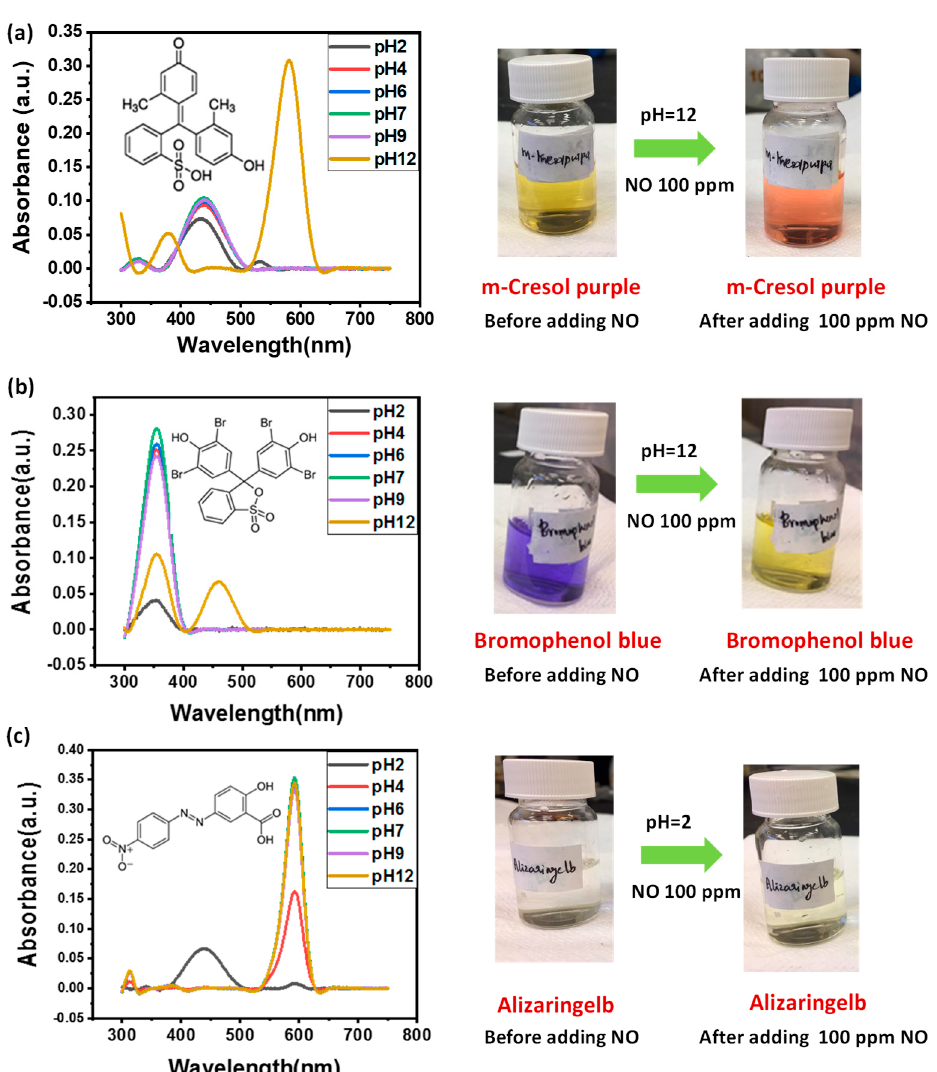
Figure 1. The effect of NO at different pH levels of dyes’ solutions. ( a ) UV–Vis spectra of m-Cresol Purple dye solutions after adding 100 ppm of NO ( left ) along with a photograph of the dye solution ( right ). ( b ) UV–Vis spectra of Bromophenol Blue dye solutions after adding 100 ppm of NO ( left ) along with a photograph of the dye solution ( right ). ( c ) UV–Vis spectra of Alizaringelb dye solutions after adding 100 ppm of NO ( left ) along with a photograph of the dye solution ( right